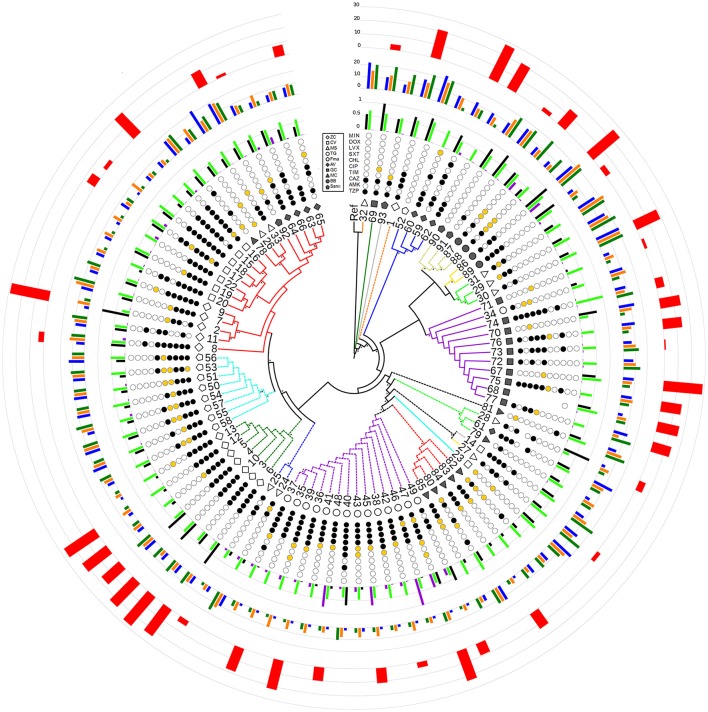
Radial cladogram inferred from a Maximum Likelihood analysis of core genome SNPs and including all phenotypic traits. Branches are colored according to ST, and dashed branches represent new STs. Innermost to outermost circles represent: (i) patient IDs (ZC, empty diamond; CV, empty square; MS, empty triangle; TG, empty circle; FMa, empty pentagon; AV, full diamond; GC, full square; MC, full triangle; BB, full circle; SanG, full pentagon); (ii) antibiotic susceptibility profiles (codified as: white-susceptible, orange-intermediate, and black-resistant) for the following antibiotics: TZP, piperacillin/tazobactam; AMK, amikacin; CAZ, ceftazidime; TIM, ticarcillin/clavulanic acid; CIP, ciprofloxacin; CHL, chloramphenicol; SXT, trimethoprim/sulfamethoxazole; LVX, levofloxacin; DOX, doxicycline; and MIN, minocycline; (iii) biofilm biomass (black), growth rate (green), and mutation frequency (purple), normalized dividing each value by the maximum value (the out-of-range biofilm values of strains 2, 28, and 69 were reported as 1 for visualization issues); (iv) swimming (blue), swarming (orange), and twitching motility (green); (v) G. mellonella virulence scores. Bootstrap support is codified as “*” for >95% and “**” for 75–95%, placed at the nodes of the tree.